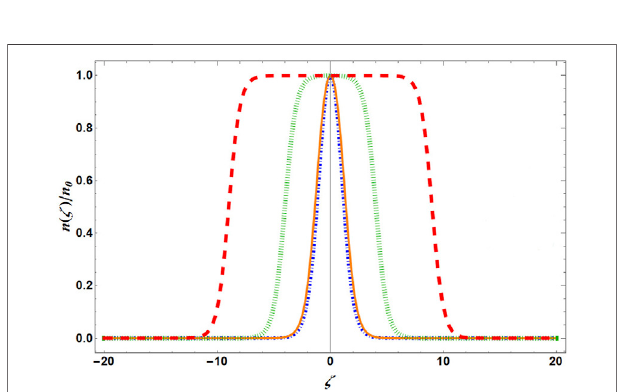
FIGURE 7 | (Color online) Spatial variation of the density pro fi le for different particle numbers. The blue dashed-dotted line describes N = 0.1, whereas the orange solid line is prepared for N = 1. The green dotted line and red dashed linedepict the density pro fi le for N = 10and 20,respectively. The density is normalized by the peak density n 0 , where n 0 = n ( ζ )| ζ =0 .